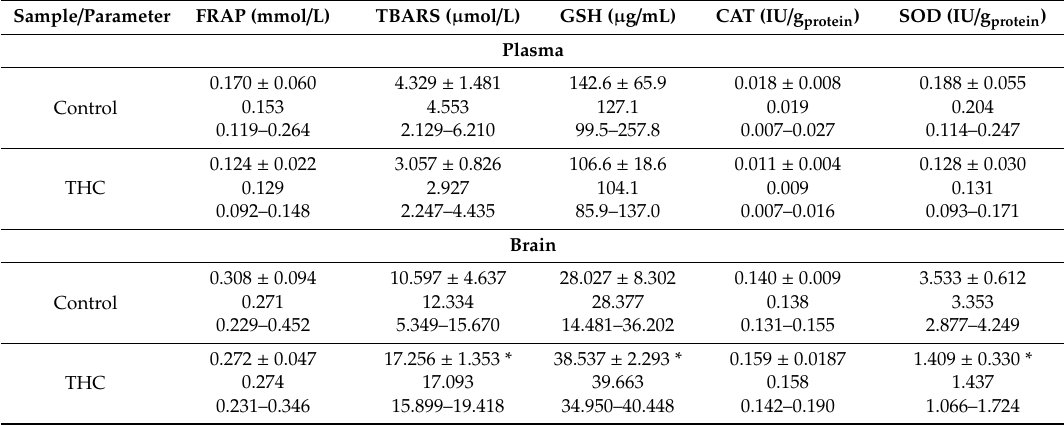
Table 1. The levels of thiobarbituric reactive substances (TBARS), glutathione (GSH), ferric reducing antioxidant power (FRAP), catalase (CAT) and superoxide dismutase (SOD) activity in the plasma and brain tissue of male Wistar rats after 1-day treatment with ∆ 9 -tetrahydrocannabinol (THC) and in the respective controls.